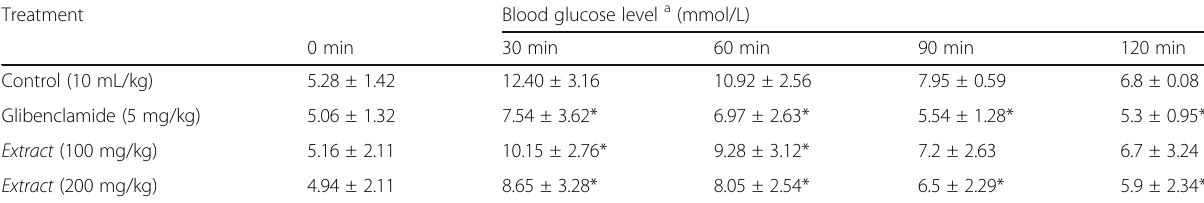
a Values represent as mean ± SD, n = 5, * P < 0.05 vs. control, Student ’ s t